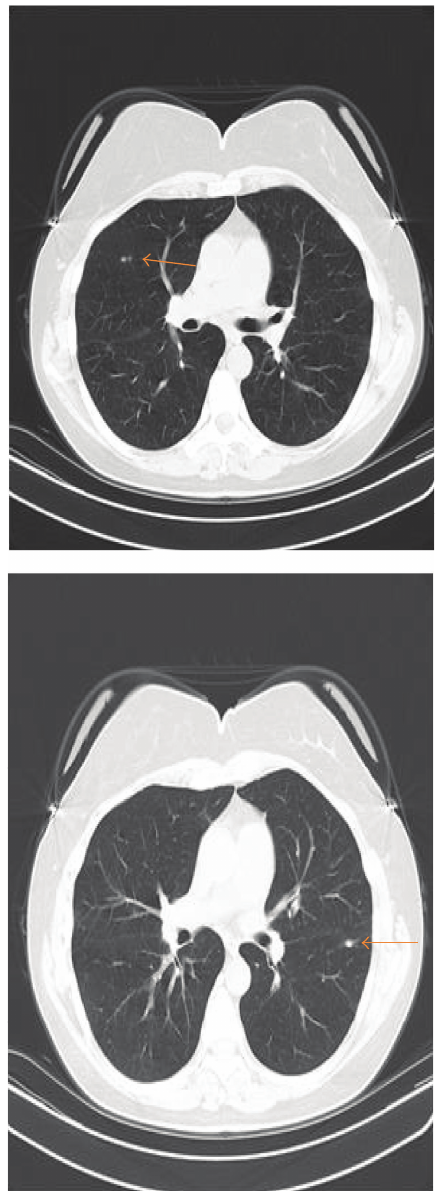
Figure 3: Chest CT scan, revealing bilateral